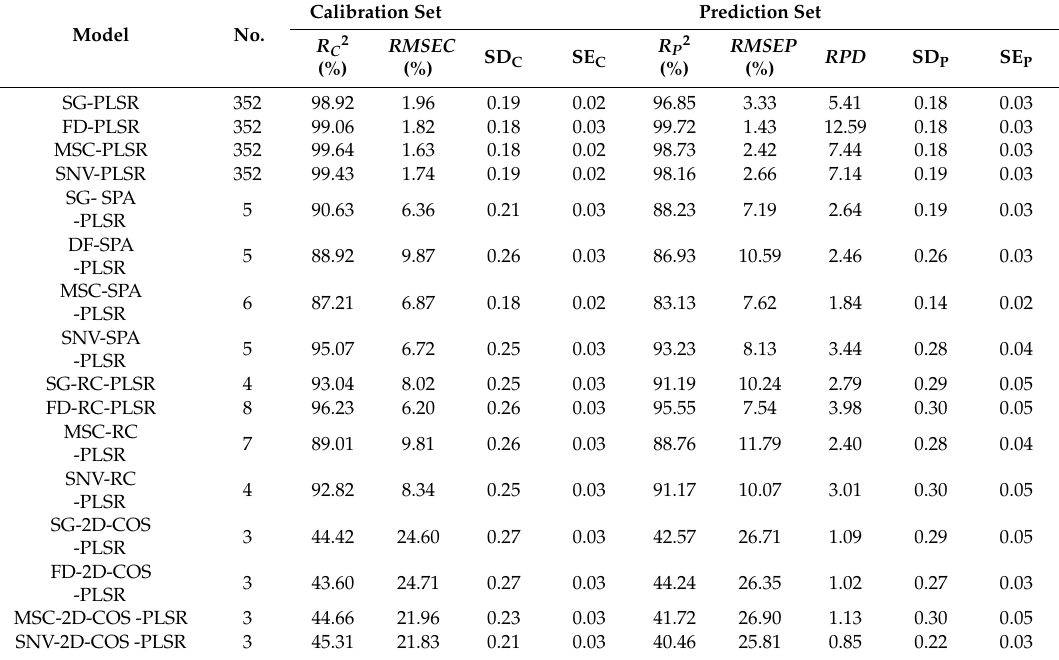
Table 5. Evaluating parameters of the PLSR model of the back region.